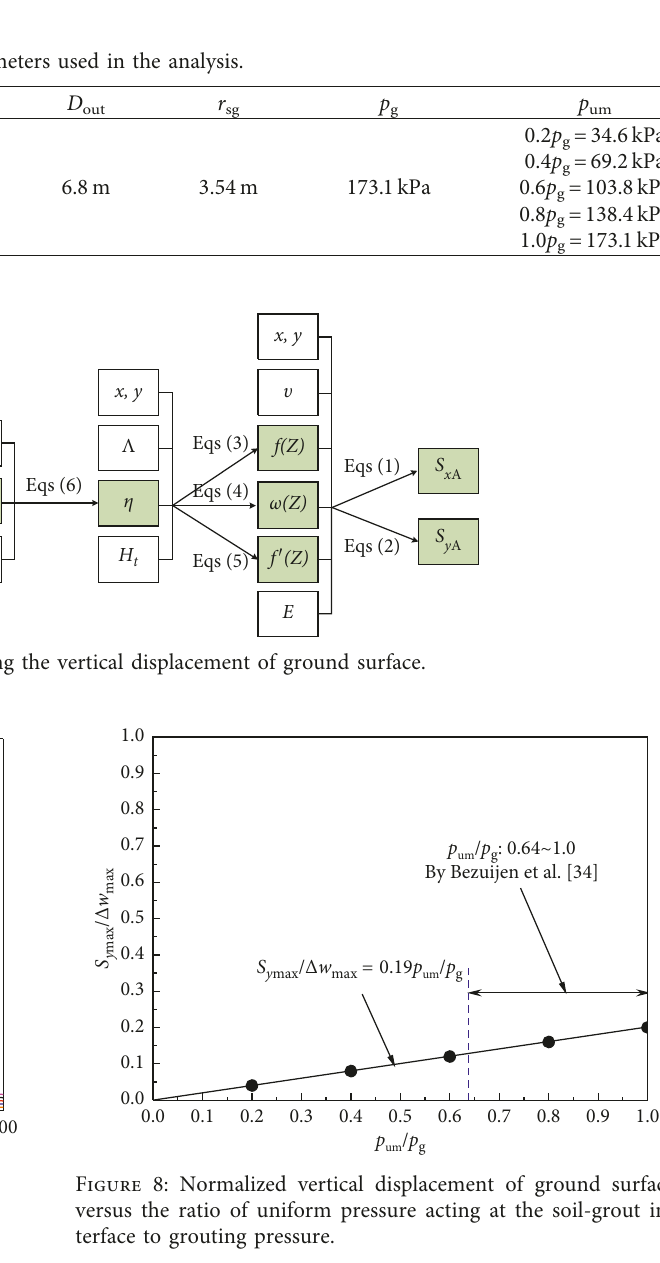
Figure 7: Variation of calculated vertical displacement of ground surface with the horizontal distance to the tunnel centre for dif- ferent five different values of the uniform pressure at the soil-grout interface.